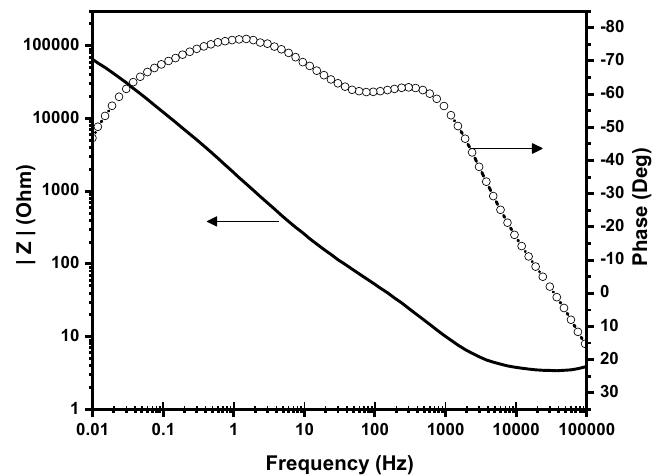
Figure A1. Bode plot performed at OCP and in NaOH(1M).